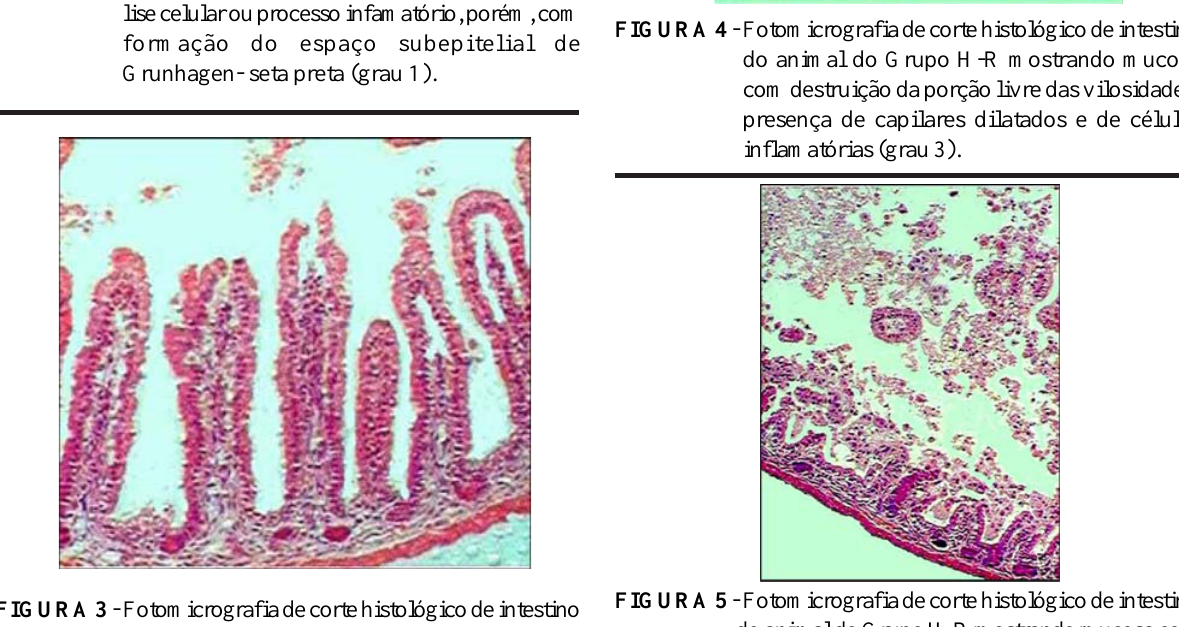
FIGURA 3 - Fotomicrografia de corte histológico de intestino do animal do Grupo H-R mostrando mucosa com presença de lises celulares, formação do espaço subepitelial de Grunhagen e espaçamento aumentado entre as vilosidades (grau 2).